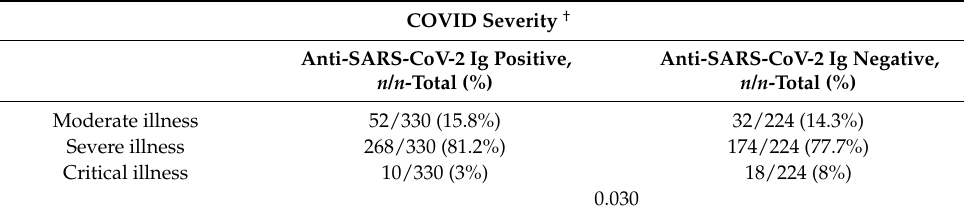
Table 2. Baseline COVID-19 severity of the cohort of patients with positive anti-S-SARS-CoV-2 immunoglobulins and the cohort of patients with negative anti-S-SARS-CoV-2. COVID Severity † Anti-SARS-CoV-2 Ig Positive, n / n -Total (%)